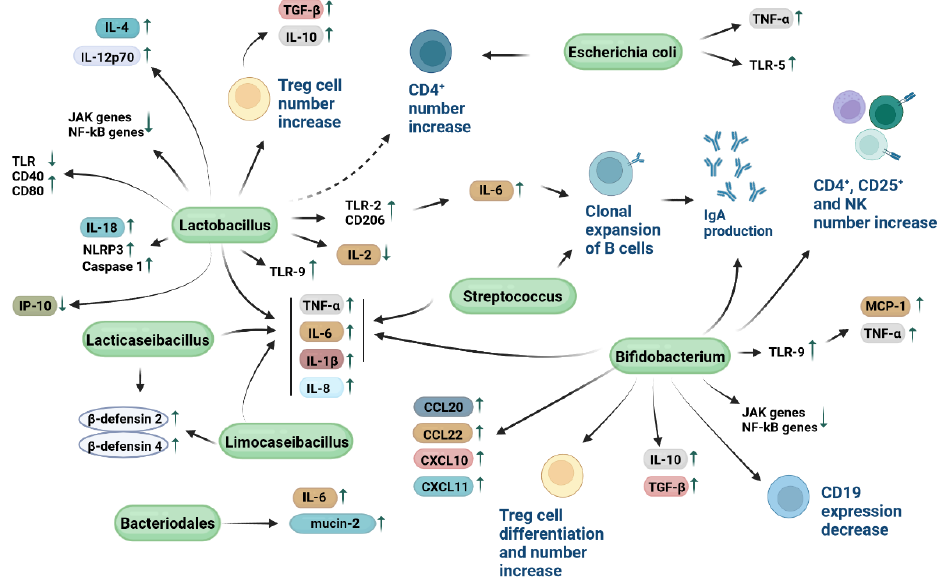
Figure 2. Mechanisms of action of probiotic bacteria. Lactobacillus can (i) stimulate T cell regulatory cells (Treg cells) to produce TGF- β , interleukin-10 (IL-10), and IL-8, (ii) increase levels of secreted IL-6 secreted in a Toll-like receptor (TLR)-2-dependent manner, thereby inducing the clonal expansion of all IgA-producing B cells, while also stimulating the expression of macrophage mannose receptor CD206, (iii) inhibit the expression of Janus kinase (JAK) and nuclear factor kappa-light-chain-enhancer of activated B cells (NF- κ B) genes, (iv) increase the release of IL-12p70 and IL-4, (v) reduce the TLR expression and increase CD40 and CD80 expressions, (vi) degrade the proinflammatory chemokine IFN- γ -inducible protein 10 (IP-10), (vii) increase the expression of TLR-9, and (viii) favor the expres- sion of nucleotide binding oligomeric domain-like receptor protein 3 (NLRP3), cysteine proteinase-1 (Caspase-1), and IL-18. Lacticaseibacillus and limocaseibacillus can induce β -defensins 2 and 4 and IL-8 expressions. Distinct studies reported opposing data on TLR expression. Bifidobacterium can (i) inhibit the expression JAK and NF- κ B genes, (ii) favor the overexpression of IL-10 and TGF- β , while, at the same time, stimulate the production of IgAs, (iii) favor Treg cell differentiation, (iv) increase the total helper (CD4+) and activated (CD25+) T lymphocytes and NK cells, (v) reduce the expression of CD19 on B cells, (vi) induces the production of monocyte chemoattractant protein 1 (MCP-1) and TNF- α through TLR-9 stimulation, and (vii) increase the number of Foxp3(+) T reg- ulatory cells and the release of CCL20, CCL22, CXCL10, and CXCL11. Escherichia coli can induce the expression of TLR-5 and TNF- α as well as increase the number of CD4+ cells. Bacteroidales stimulates the release of IL-6 accompanied by the expression of mucin-2 and claudin-1. Lactobacil- lus, lacticaseibacillus, limocaseibacillus, bifidobacterium, and streptococcus can favor the release of TNF- α , IL-6, IL-1 β . Streptococcus can induce clonal expansion of B cells stimulated to release IgAs. Dash arrow: conflicting data have been reported on the effect of lactobacilli in increasing CD4+ T cell